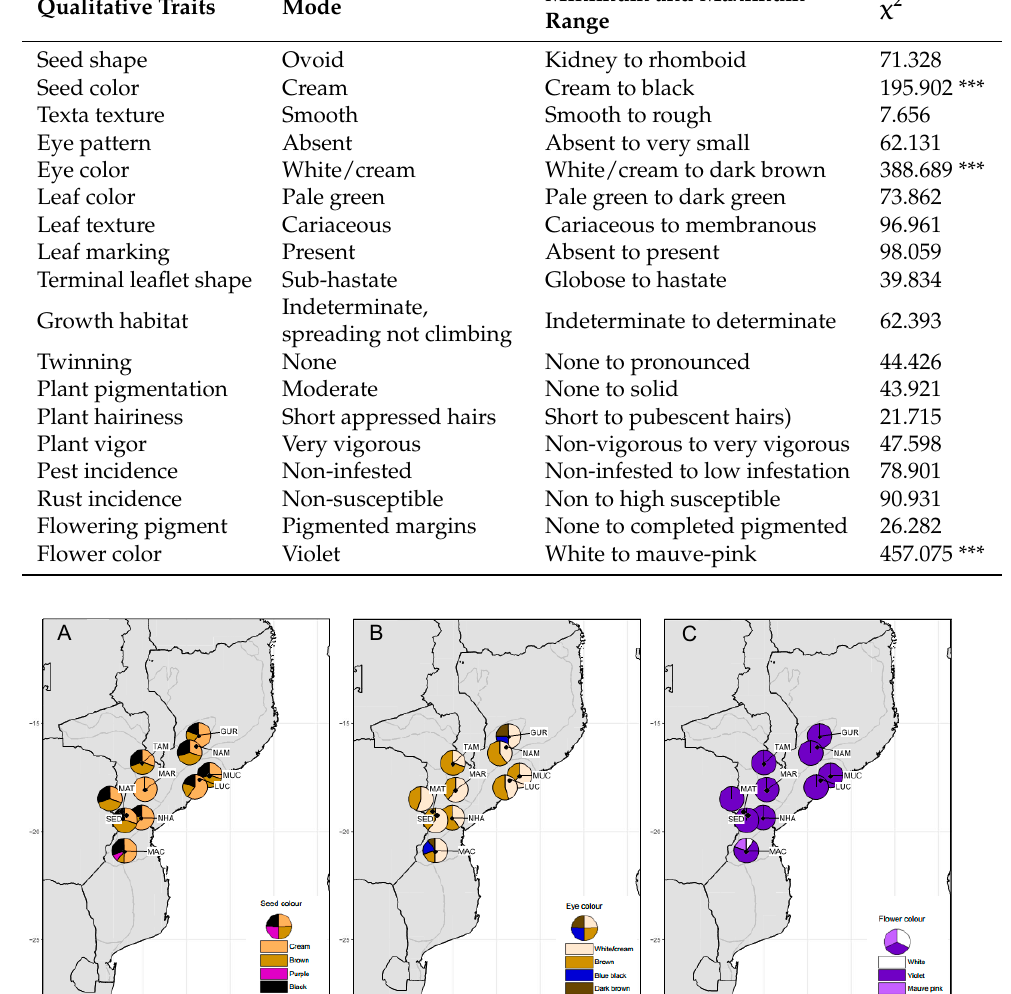
Table 3. Qualitative trait mode value, and maximum and minimum range values for Vigna unguiculata populations studied. Comparisons between landraces were performed with a Chi-square test. from white/cream to dark brown with a predominance of white; flower color varied from violet to mauve-pink with a predominance of violet (Figure 4). The population of Machaze showed the widest range of traits (Figure 4).